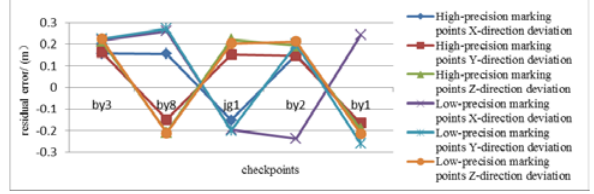
Figure 2. line chart of data residual error